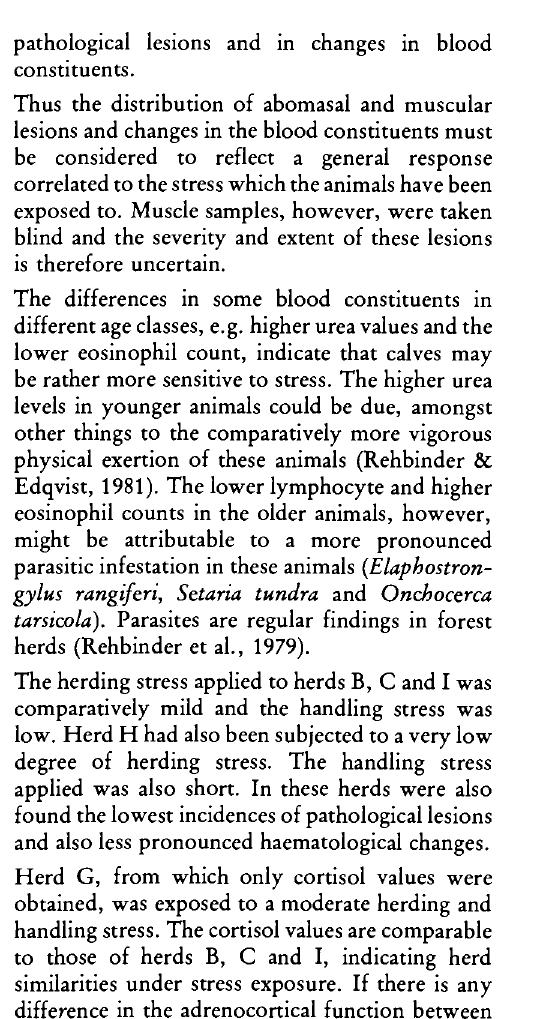
Fig. 7. Periferal blood plasma levels of ASAT. Nivåer av ASAT i perifer blodplasma. changes have not been taken into consideration and it is worth pointing out that the blood samples from Group A (the unstressed controls) were taken after a knife-cut in the jugular